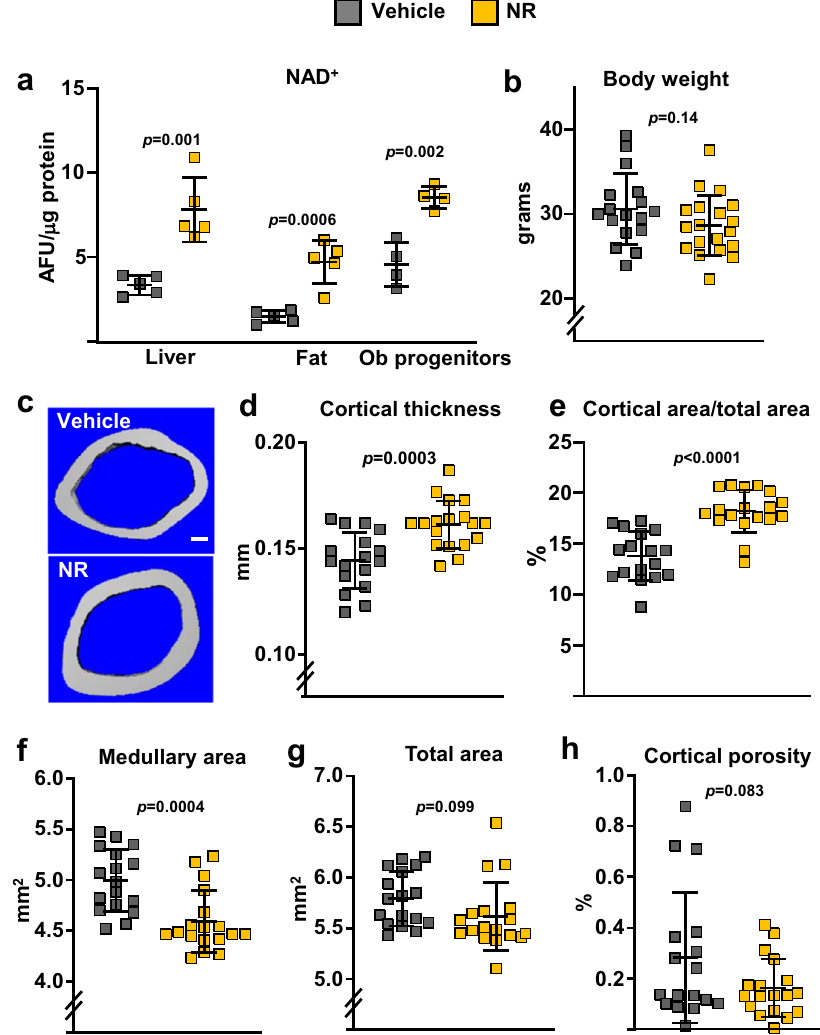
Fig. 3 Administration of NR to aging mice attenuates the loss of bone mass. Twelve-month-old C57BL/6 female mice were treated without or with 12 mM NR, administered in the drinking water, until sacri fi ce at the age of 20 months. a NAD + levels in liver, fat tissues, and cultured bone marrow stromal cells ( n = 4 – 5/group). b Body weight before sacri fi ce ( n = 18 – 19/group). c Representative images of cortical bone, d cortical thickness, e cortical area/total area, f medullary area, g total area, and h cortical porosity by micro ‐ CT at the distal metaphysis of femur ( n = 18 – 19/group). Data represent mean ± SD; p values by two-tailed unpaired t